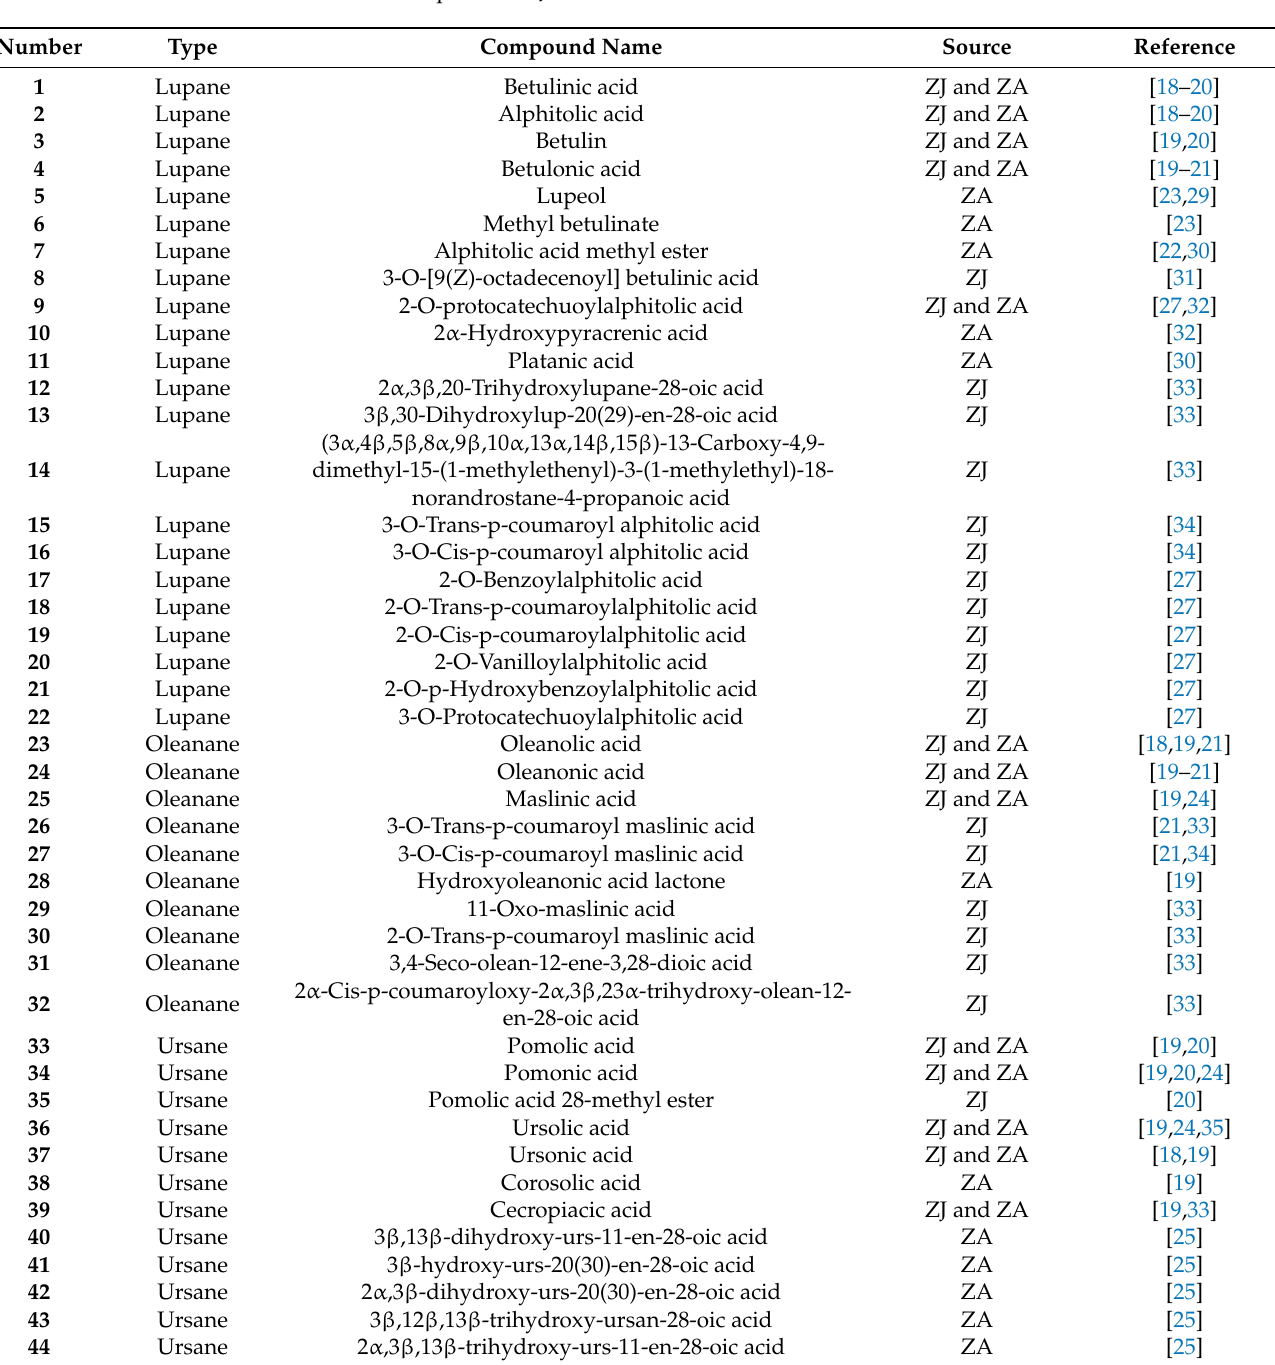
Table 1. Triterpenes in ZJ and